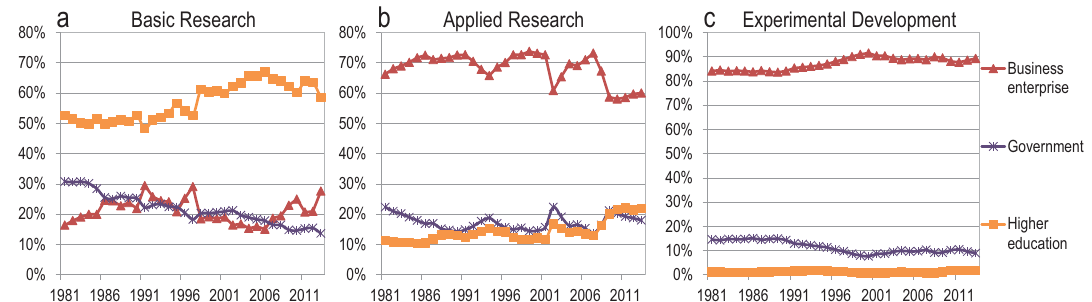
Fig 3. Funding of (A) basic research, (B) applied research and (C) experimental development, by sector of execution, United States, 1981–2013 (OECD Statistics).